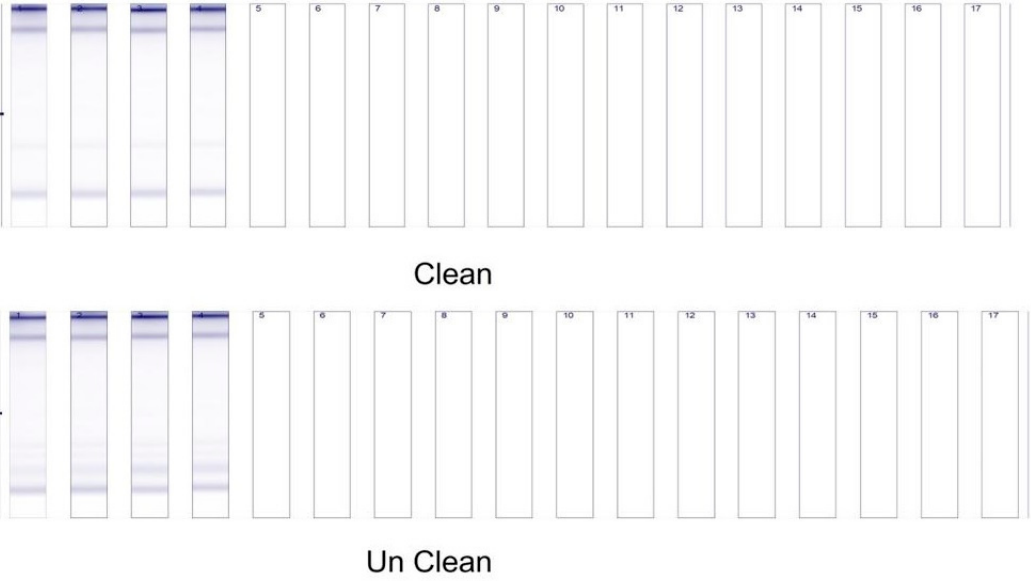
Figure 6. The tape station for cleaned and uncleaned extracted RNA samples using the RNAeasy micro kit for MCF-7 cells after 0, 20, 40, and 80 μ M.